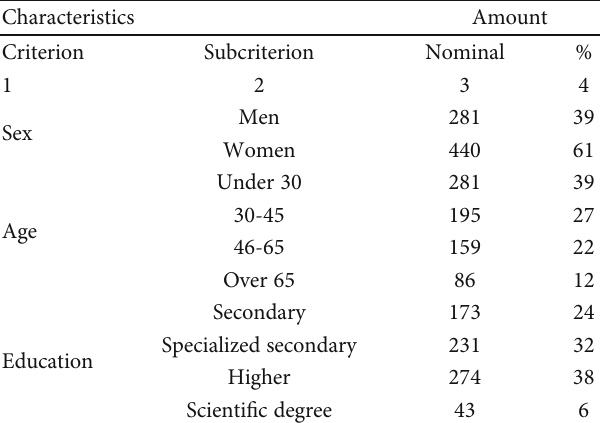
Table 2: Characteristics of respondents participating in the survey.